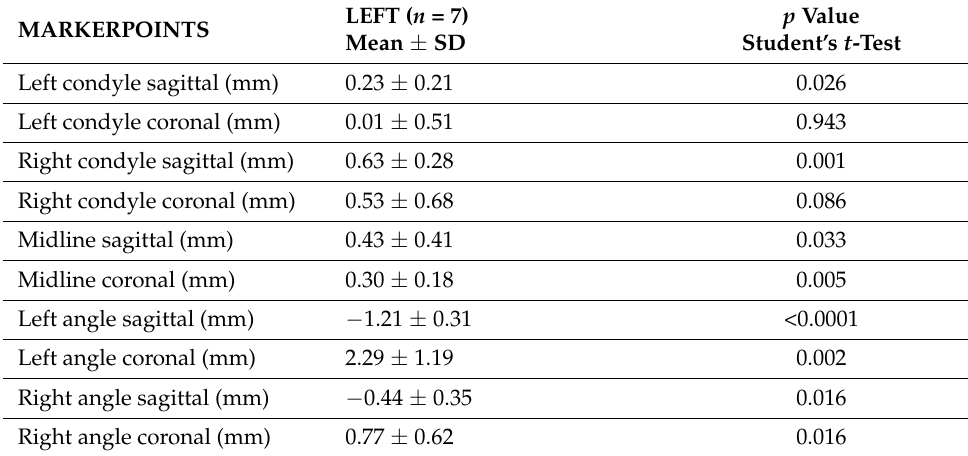
Table 3. Comparison between mean values of marker points measure and “zero” for patients treated on left-hand side. p value < 0.5 has been considered significant.